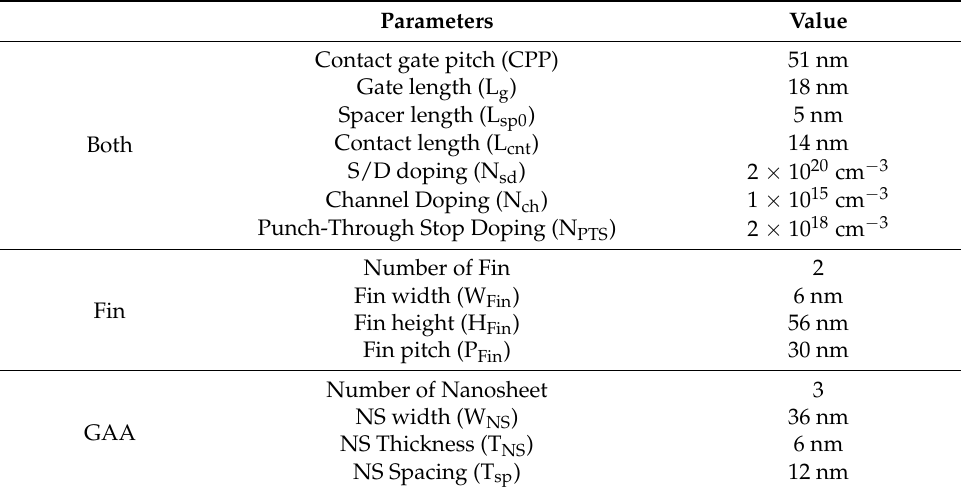
Figure 1. 3D schematic view of the ideal device structure and 2D cross-sections across and along the channel of ( a ) FinFET and ( b ) NSFET with the same footprint. Table 1. Key Device Parameters for 5 nm Node Fin and NS FETs.